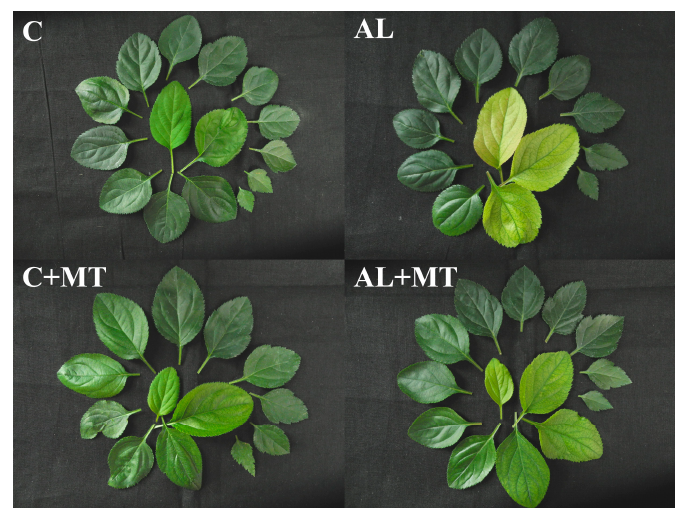
Figure 1. Phenotypes of Malus hupehensis Rehd. leaves in response to alkaline stress and/or melatonin treatment. C: normal growing conditions, pH 6.0–6.5, no melatonin treatment; AL: alkaline stress treatment with 2 mM Na 2 CO 3 /NaHCO 3 (1:1), pH 8.5–8.8; MT: 5 µM melatonin treatment. Leaves were listed clockwise from youngest to oldest.